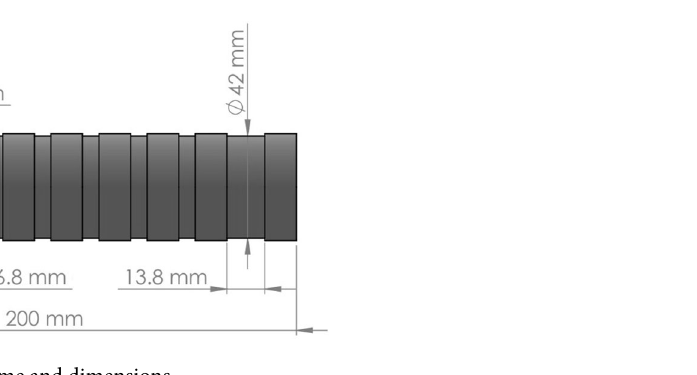
Figure 1. Workpiece scheme and